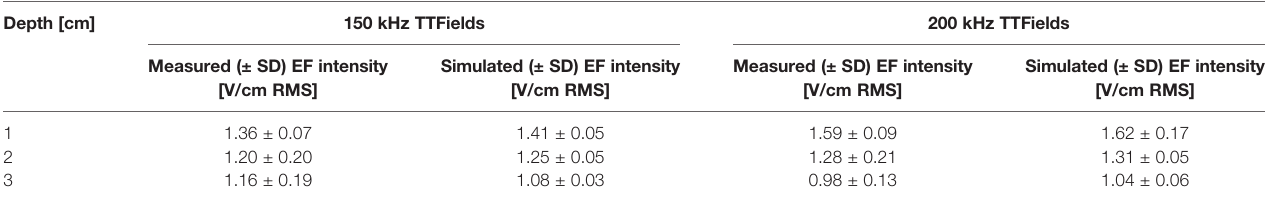
Currents were selected for each frequency based on the results of Table 1 .